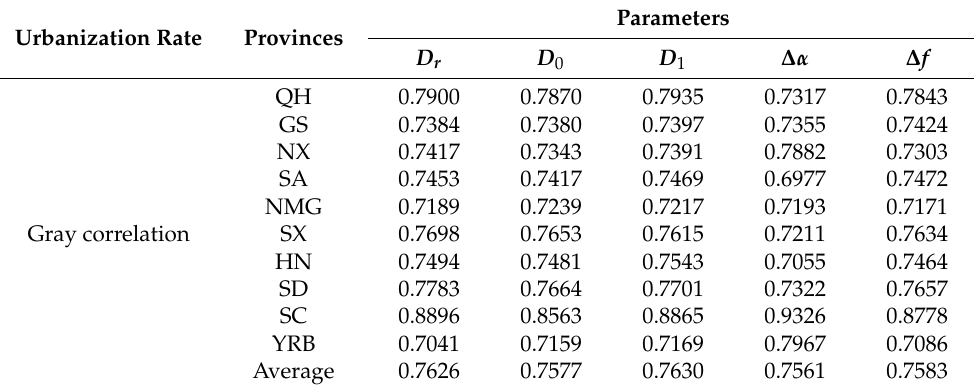
Table 2. Gray correlation between the river network changes and the urbanization process of provinces in the Yellow River